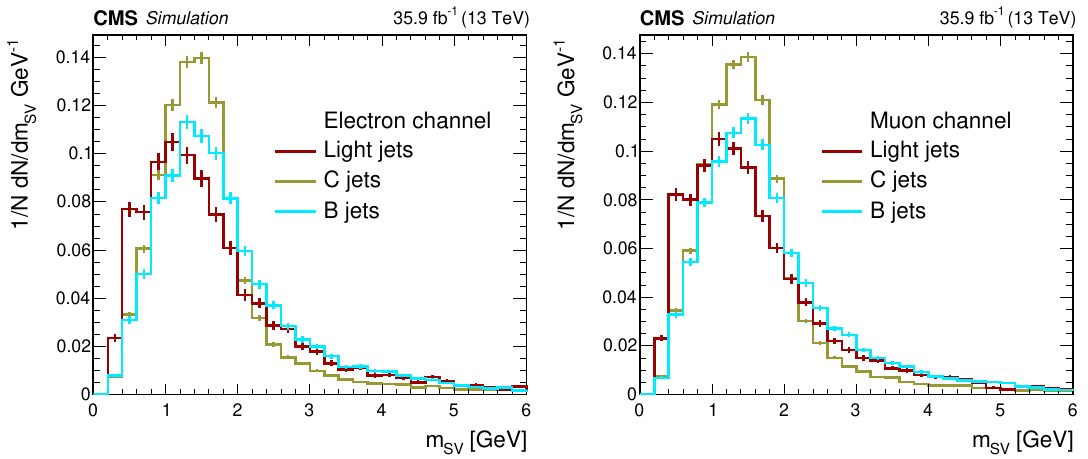
c -tagged central jet, for T